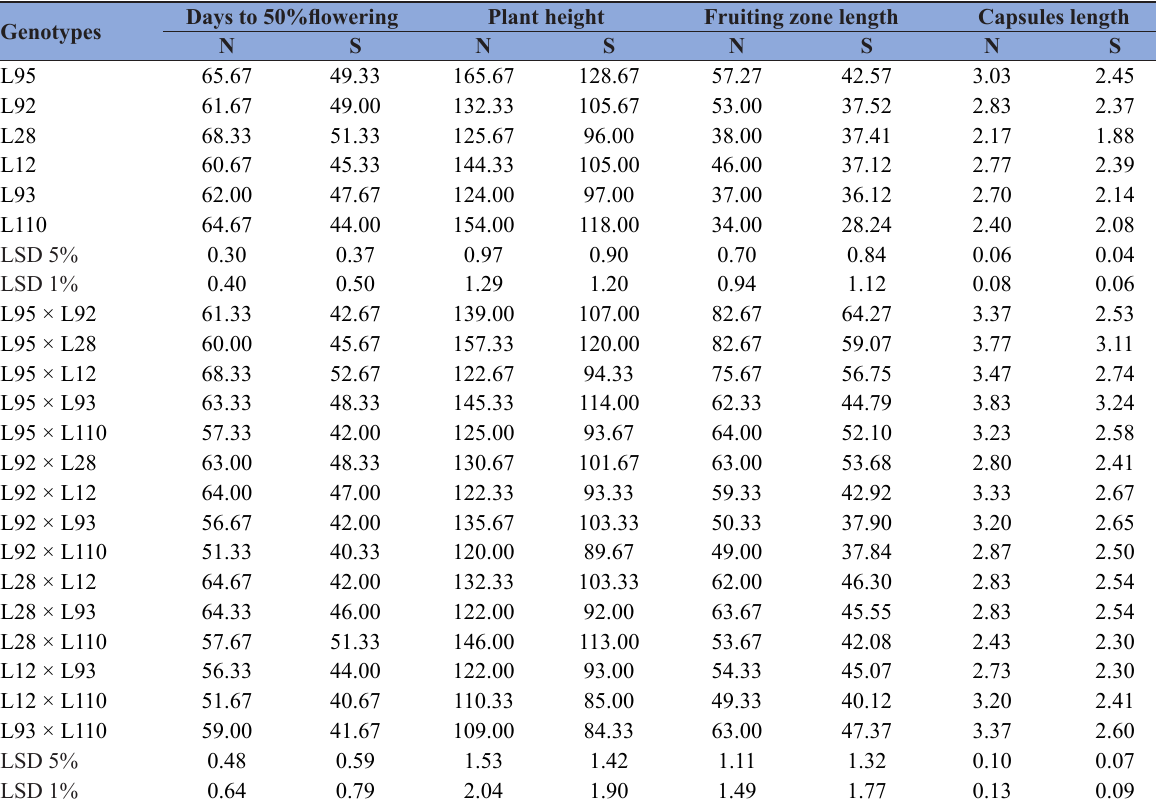
Table 5a. Mean performance of six parental sesame genotypes and their 15 F height, fruiting zone length and capsules length under normal irrigation (N) and water stress conditions (S) in 2019